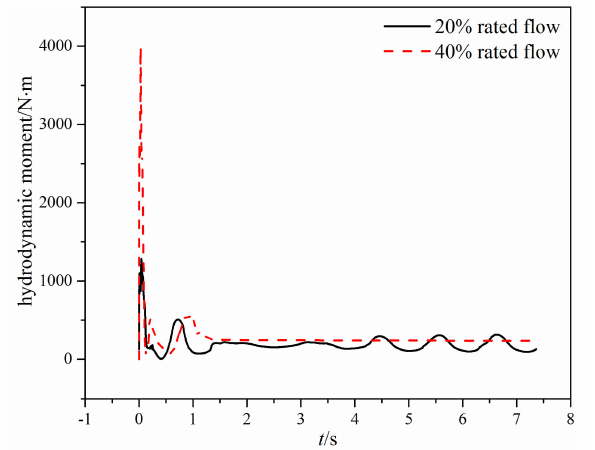
Figure 13. The time-varying hydrodynamic moment under di ff erent mass flow